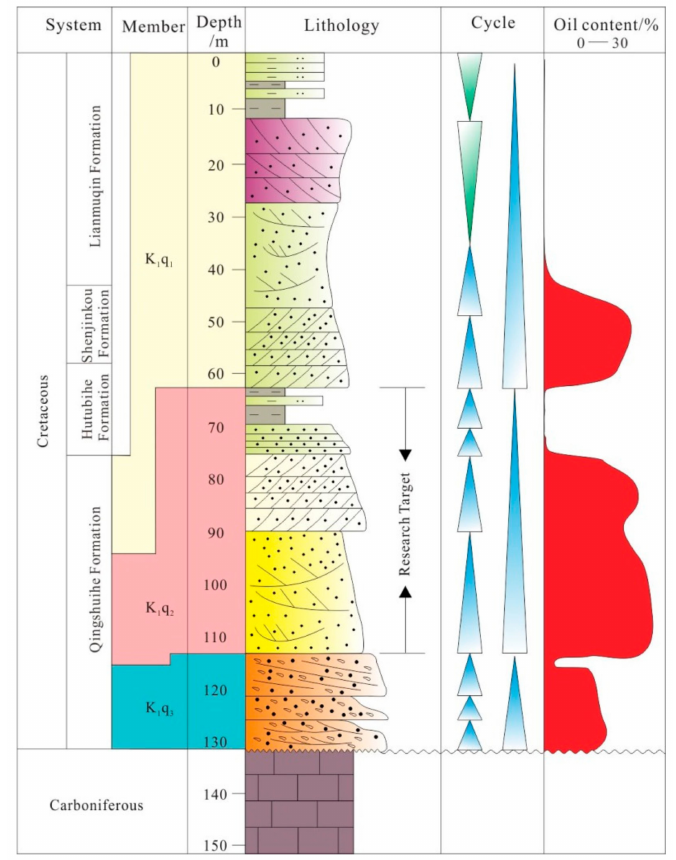
Figure 2. Comprehensive geology column of the Qingshuihe